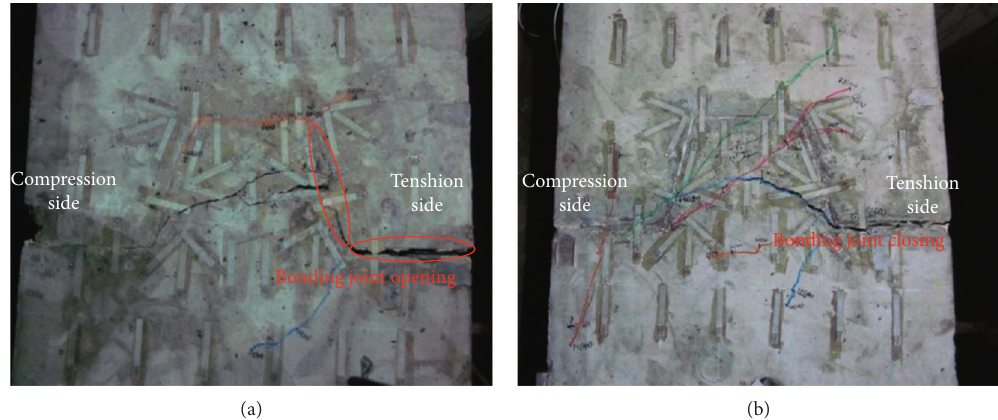
Figure 6: Failure modes of joints with modified epoxy resin and cement-based grouting materials. (a) Cement-based grouting materials cracking in seam surface, (b) modified epoxy resin cracking in the concrete cover.